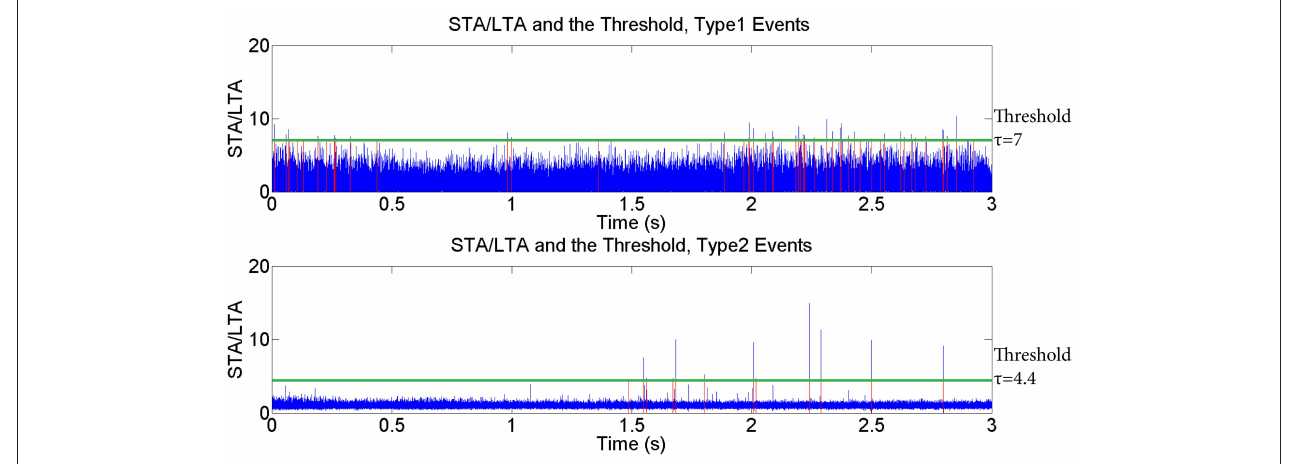
FIGURE 8 | STA/LTA detection plots for Type 1 (upper figure) and Type 2 (lower figure) events. Top: The raw signal is filtered by using a butterworth bandpass filter with corner frequencies 100Hz and 10kHz before computation. Bottom: The raw signal is filtered by using a highpass filter for frequencies higher than 100 kHz before computation. We found that some of the Type 2 events can be classified as Type 1 events since they have energy in the low frequency higher than the threshold.